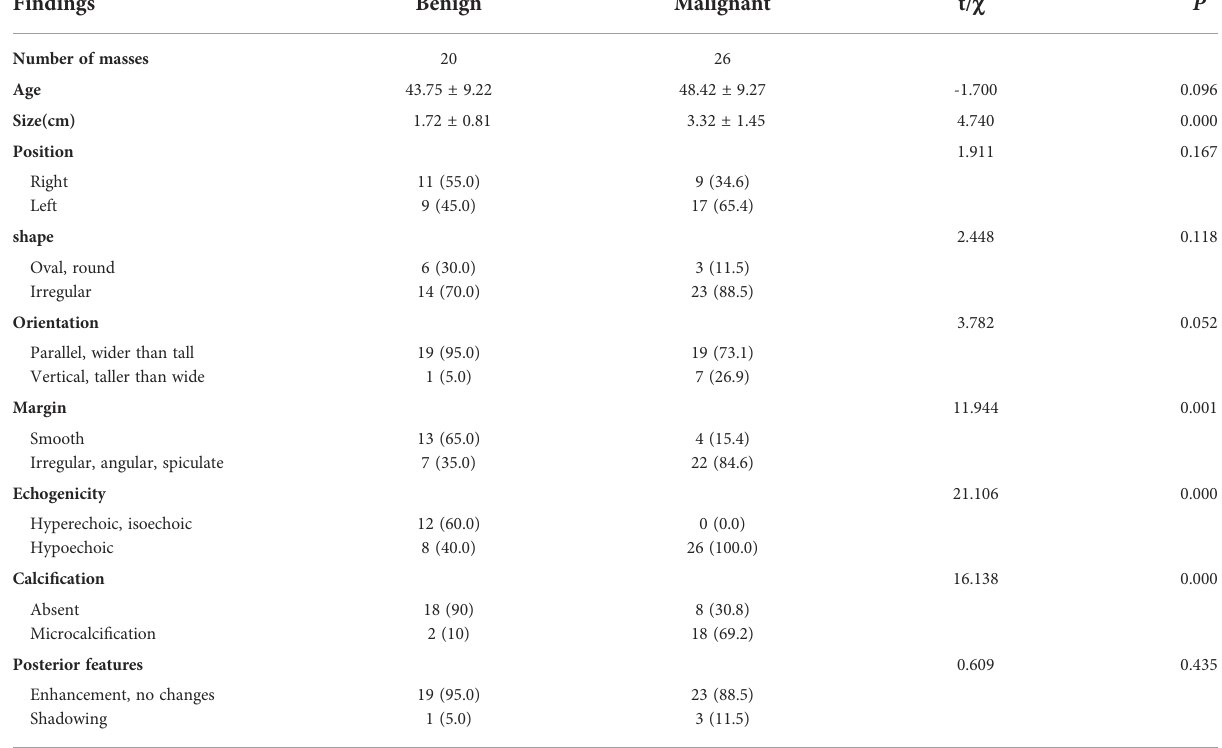
TABLE 1 Summary of clinical information from examined patients and the corresponding ultrasound characterizations of breast masses.